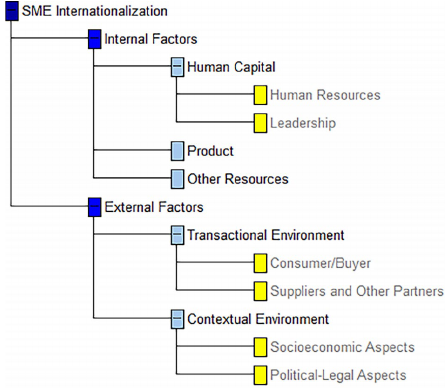
Figure 5. Tree of